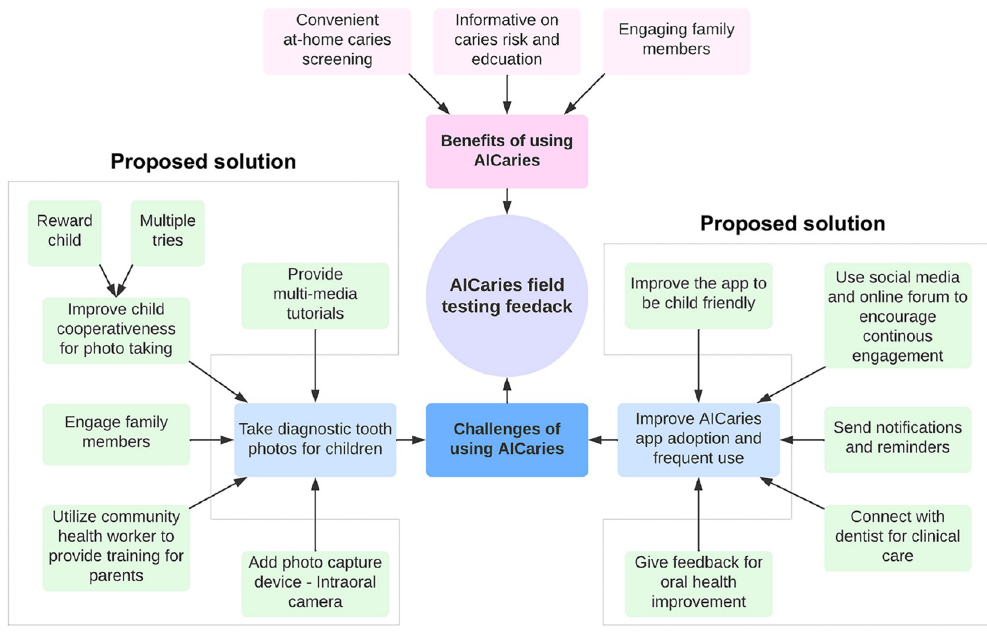
Fig 7. Challenges and Solutions perceived by AICaries app